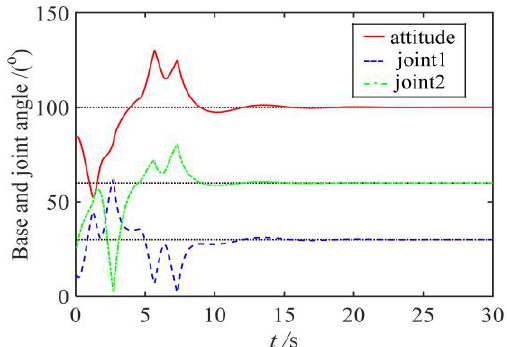
Figure 10. Base and joint angle (F C1 = 120 N · m, F O1 = 10 N · m).